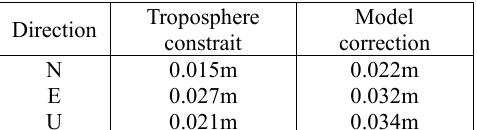
Table 2. Comparison of PPP